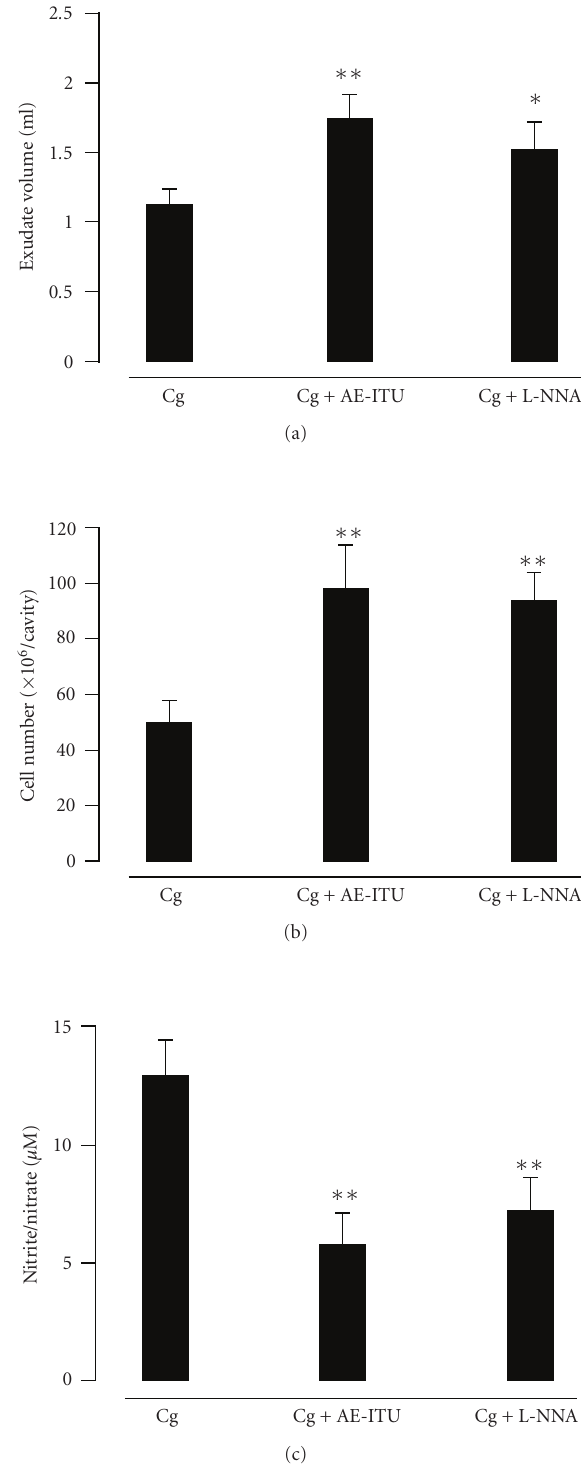
Figure 3: E ff ects of AE-ITU and L-NNA on rat Cg pleurisy and nitrite/nitrate levels. AE-ITU or L-NNA was injected into the pleural cavity immediately before Cg injection. The exudate volume (a), cell number (b), and nitrite/nitrate levels (c) in the pleural exudates were determined 6 hours after Cg injection. Data are expressed as mean ± S.E.M. of 6 to 8 rats. ∗ P < . 05, ∗∗ P < . 01 as compared to the Cg